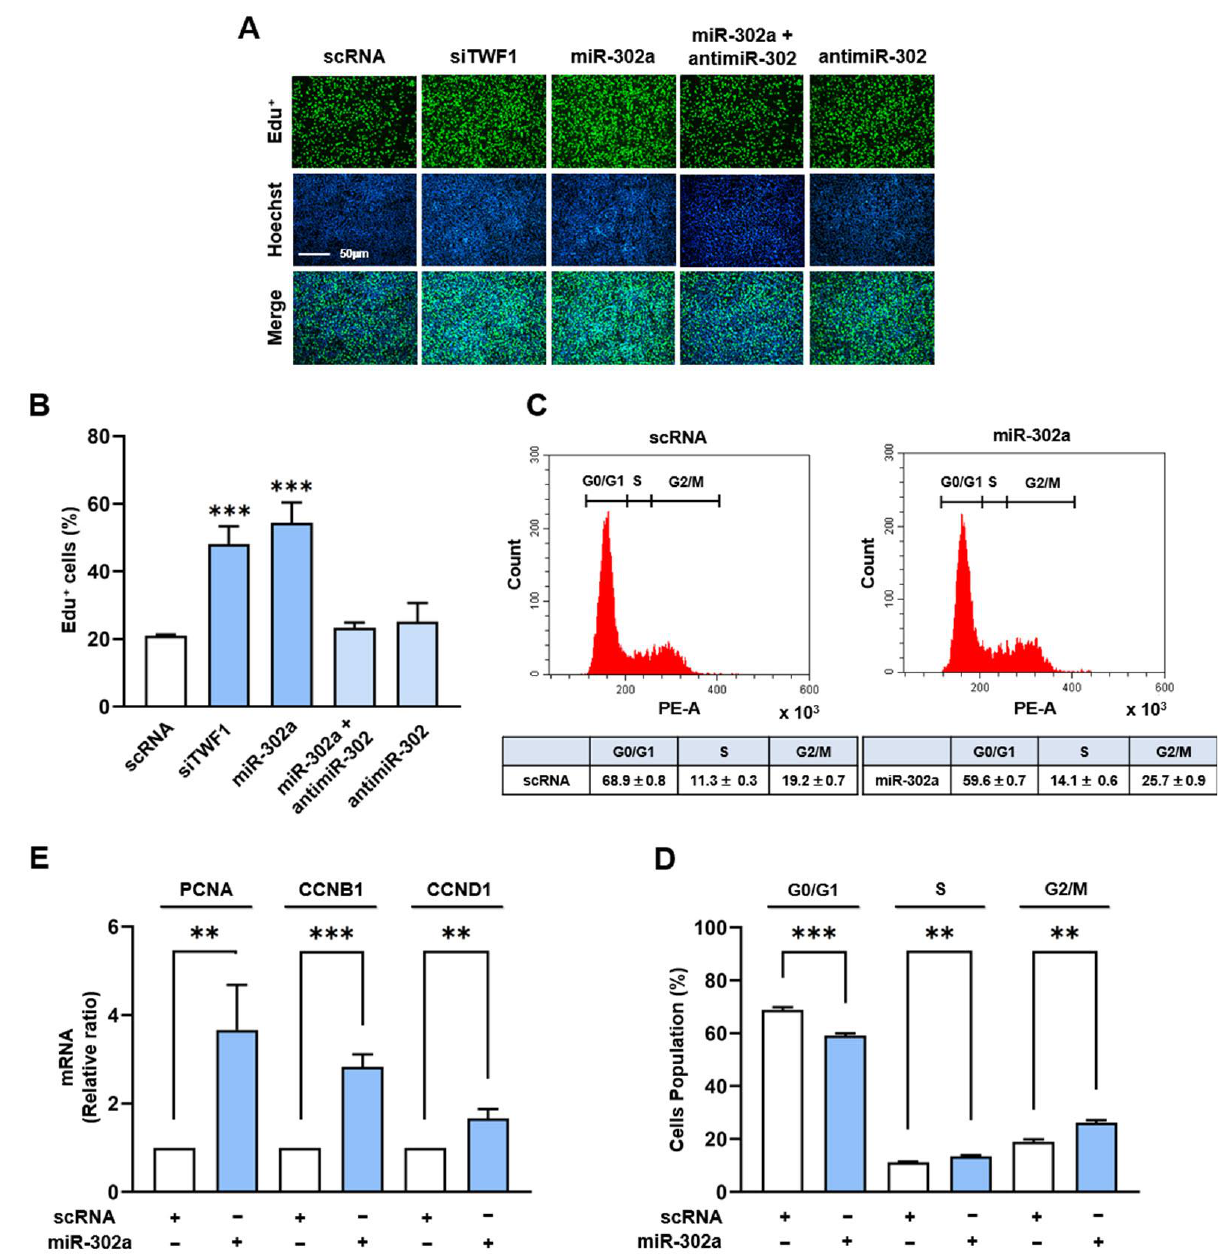
Figure 4. MiR-302a promotes myoblast proliferation. C2C12 cells were transfected with scRNA, siTWF1, miR-302a mimic, or antimiR-302 for 24 h before analysis. ( A ) EdU incorporation analysis. Cells undergoing DNA replication were labeled with EdU (green) and nuclei were counterstained with Hoechst 34452 (blue). Scale bar: 50 µ m. ( B ) Proportions of EdU-positive cells were determined using ImageJ software. ( C , D ) Representative flow cytometry results. The scatter plots of cell cycle images and cell cycle phase proportions were obtained after 24 h of transfection. ( E ) Relative expression levels of CCNB1, PCNA, and CCND1 were determined via RT- q PCR and normalized versus U6. q RT-PCR results are expressed as relative ratios versus controls (scRNA) and presented as means ± standard errors ( n > 3); **, p < 0.01; ***, p < 0.001 vs. scRNA.